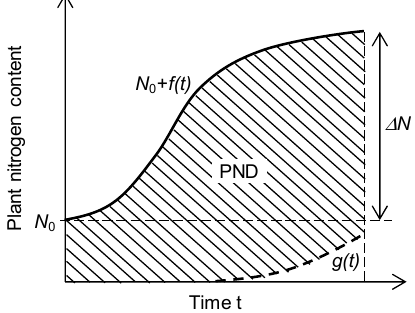
Figure 1. Diagram of time course in plant nitrogen content. N 0 , initial plant nitrogen content; f(t) , nitrogen uptake; g(t) , nitrogen loss; ∆ N , total N uptake. The area with hatching indicates the plant nitrogen duration (PND). Redrawn from Hirose [16].